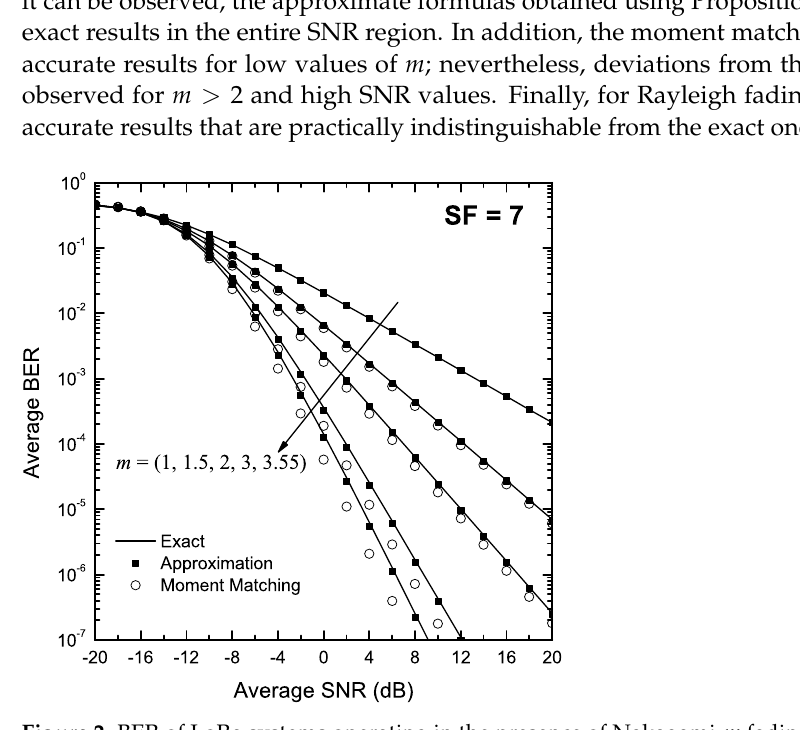
Figure 2. BER of LoRa systems operating in the presence of Nakagami- m fading as a function of the SNR, γ , for SF = 7 and various values of m